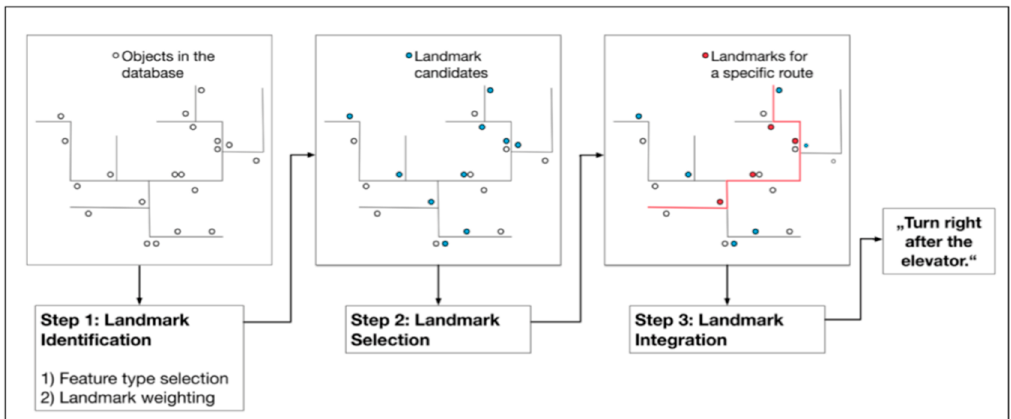
Figure 1. Overview of indoor landmark navigation model; Source: [1].